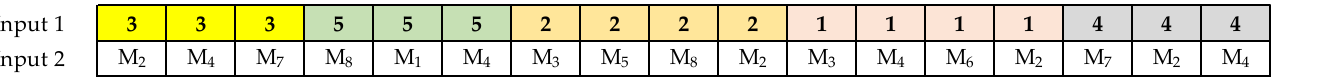
13 of 20 Table 1. Genetic algorithm parameter values. Parameter